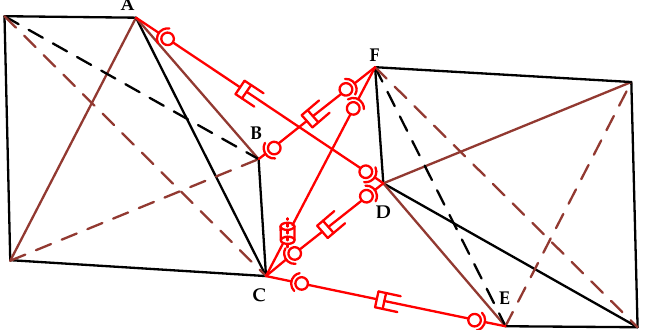
Figure 6. The sketch of the wing morphing mechanism. The red column represents the rotating pair. The red circle represents the ball joint. The red square represents the mobile pair.